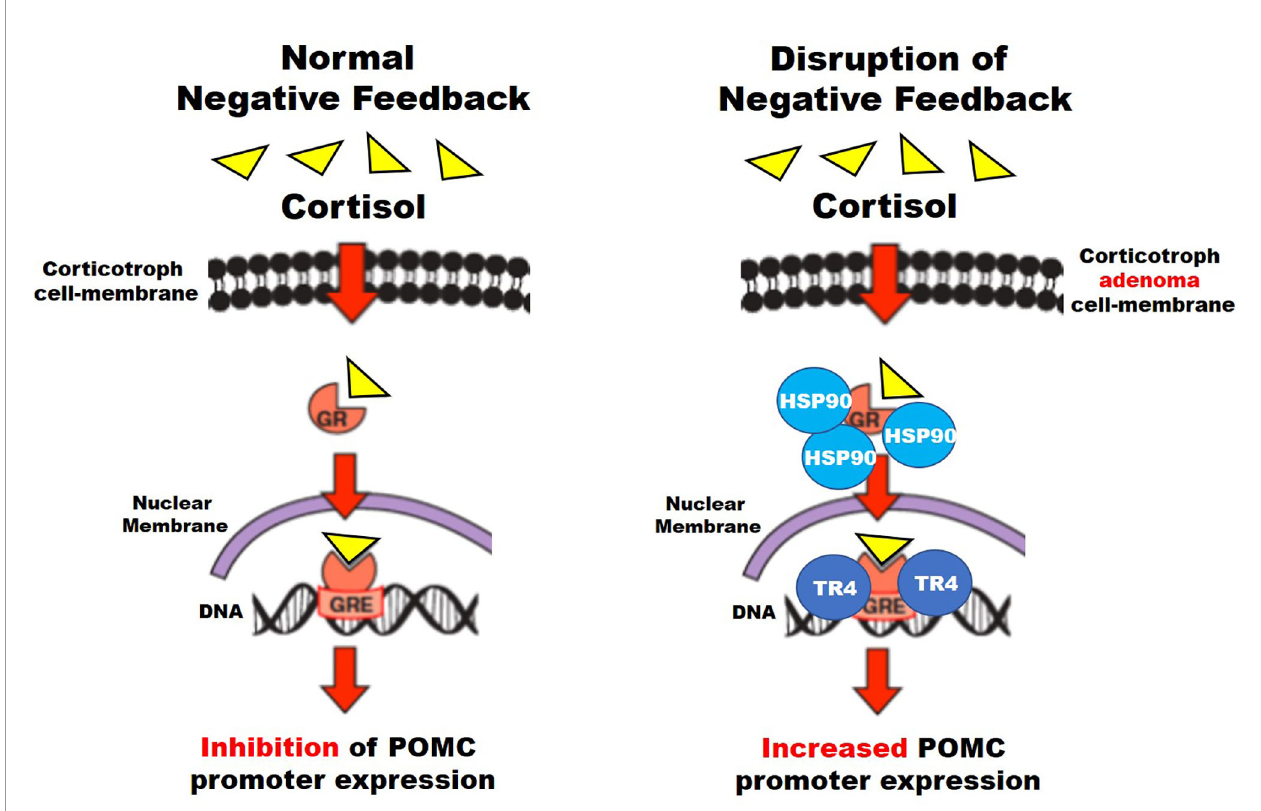
FIGURE 2 | Suggested mechanisms for disruption of negative feedback in corticotroph tumors (see text for